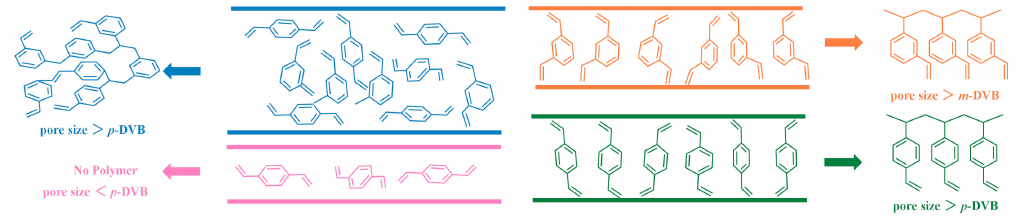
Figure 18. Mechanism of the nanochannel-e ff ected polymerization in MOFs [Cu 2 (pzdc) 2 (L)] n